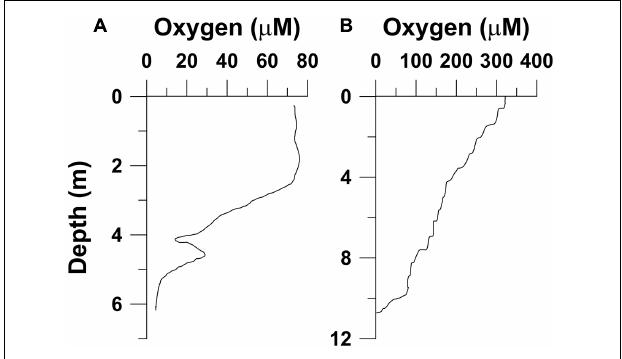
FIGURE 9 | Oxygen profiles at Rescue Station Marina in Salmiya, Kuwait (latitude 29.34 ◦ N, longitude 48.10 ◦ E) during a fish kill incident on July 19, 2011 (A) , and in Shuwaikh Port (latitude 29.36 ◦ N, longitude 47.93 ◦ E) on April 30, 2017 (B) . Redrawn from Al-Yamani et al.